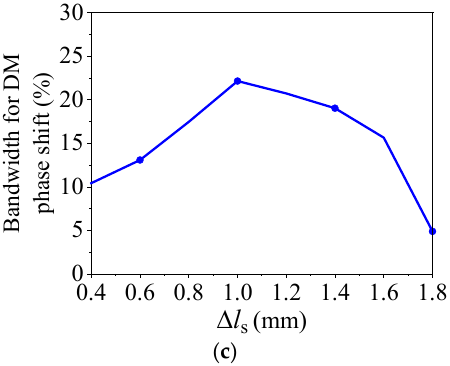
Figure 6. The simulated bandwidth for DM phase shift with ±5% phase deviation of the proposed balanced SIW phase shifter with different Δ d s , Δ w s , and Δ l s . ( a ) With different Δ d s . ( b ) With different Δ w s . ( c ) With different Δ l s .